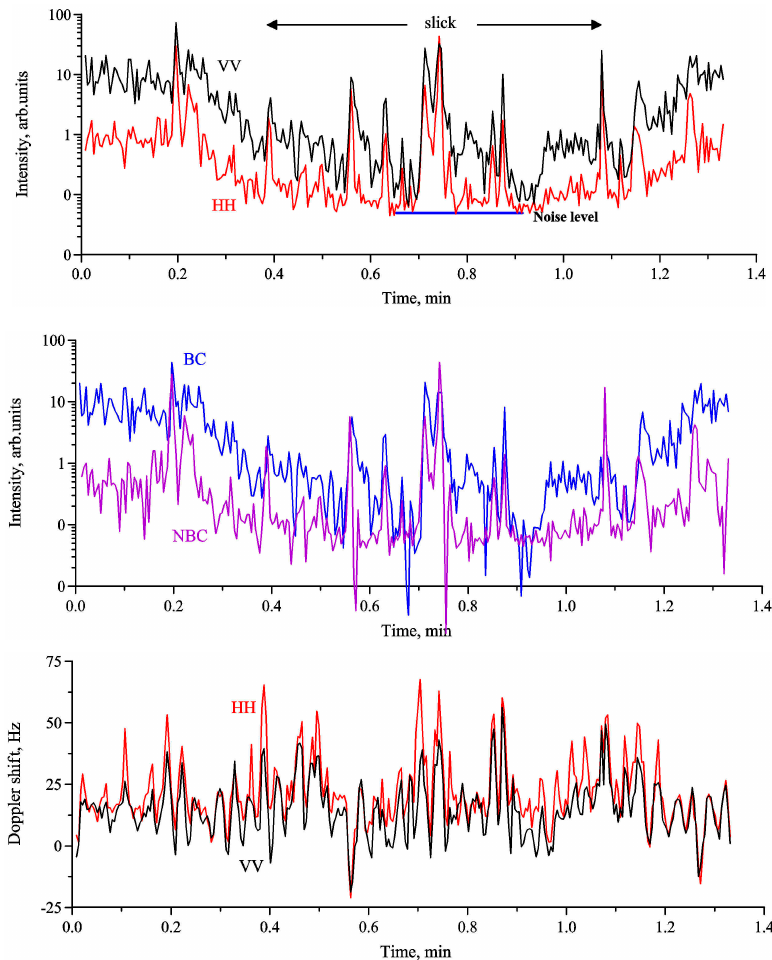
Figure 7. Same as in Figure 6 but for the case of slick, wind velocity is 10 m/s.